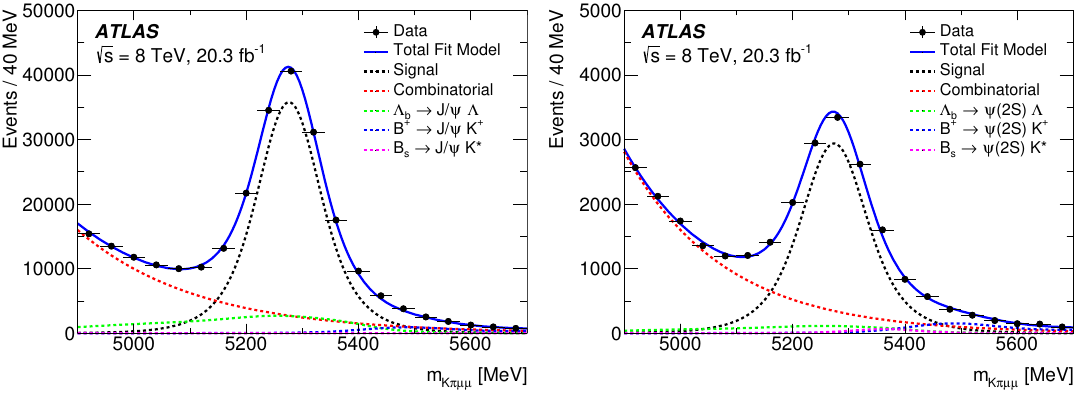
Figure 3 . Fits to the K(cid:25)(cid:22)(cid:22) invariant mass distributions for the (left) K control region samples. The data are shown as points and the total (cid:12)t model as the solid lines. The dashed lines represent (black) signal, (red) combinatorial background, (green) (cid:3) (blue) B + background and (magenta) B 0